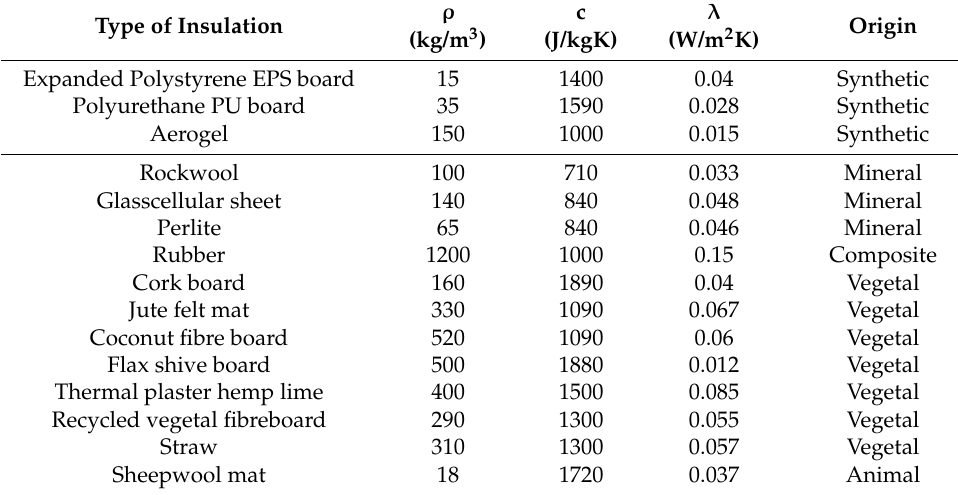
Table 5. Type and thermophysical properties of the insulation used in the optimised